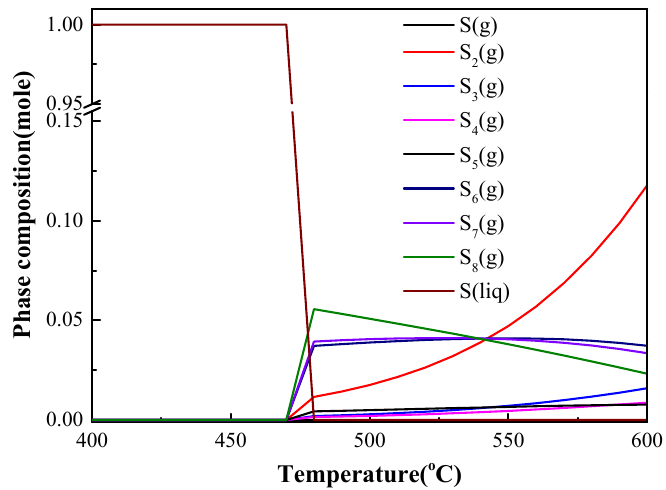
Figure 4. Phase composition as a function of temperature based on 1 mole solid sulfur.